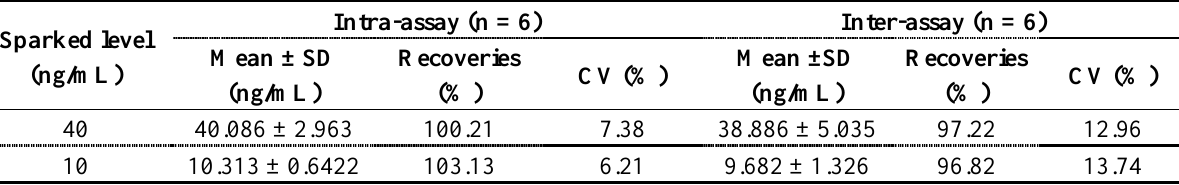
Table 2. Recovery of sandwich ELISA for